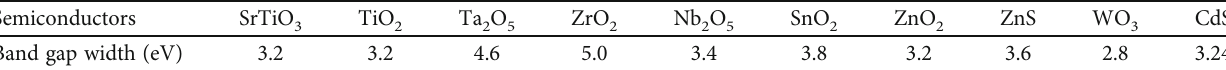
Table 2: Common semiconductors and band gap